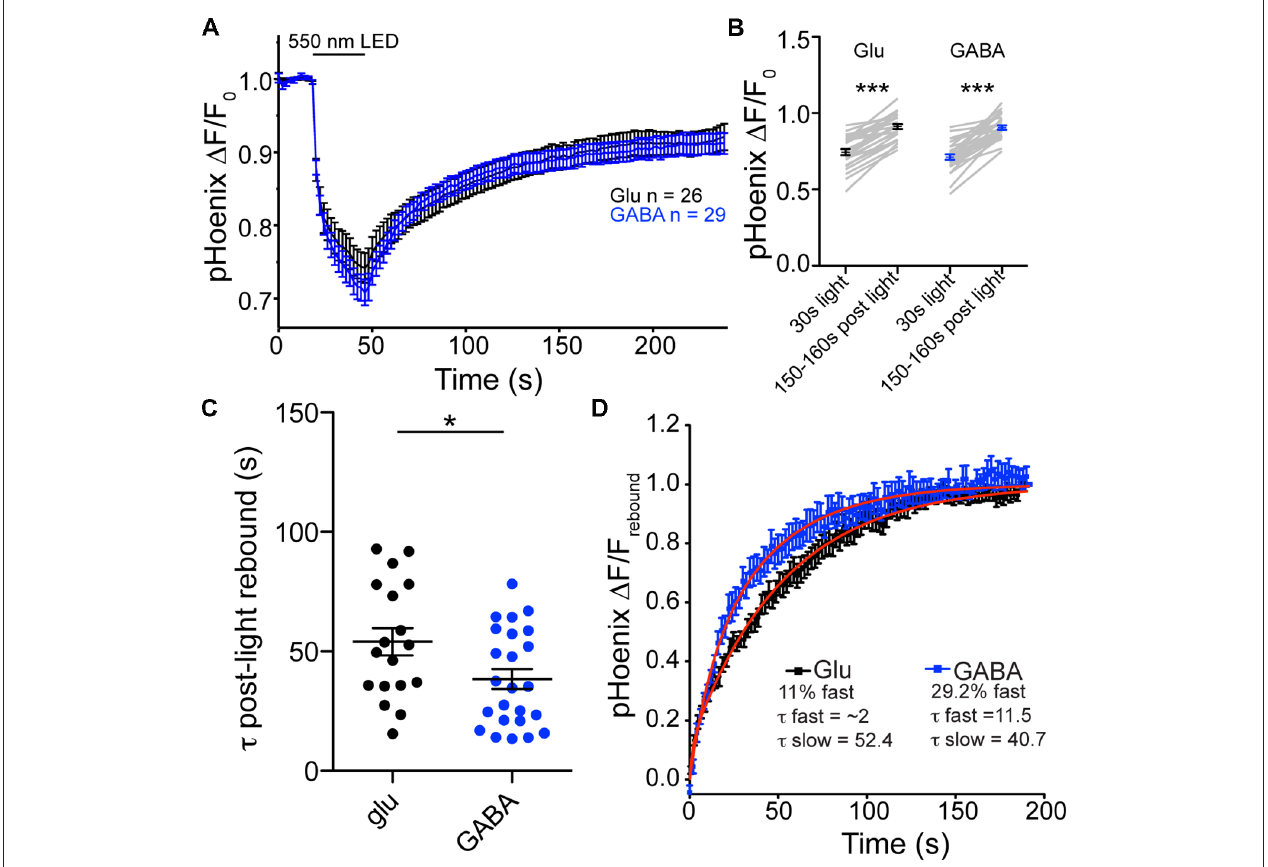
FIGURE 5 | Proton efflux is faster from GABAergic SVs than glutamatergic SVs after pHoenix-induced acidification. (A) Average decrease in pHoenix fluorescence normalized to baseline fluorescence with 550 nm light stimulation (30 s) in VGAT-cre cultures pre-treated with bafilomycin (>2 h, 1 µ M) in glutamatergic (black; n = 26 images; four independent cultures) or GABAergic (blue; n = 29 images; four independent cultures) synapses. (B) Comparison of normalized pHoenix fluorescence at time points immediately following a 30 s stimulation with 550 nm light and 150–160 s after light cessation in glutamatergic (black) and GABAergic (blue) synapses. Significance determined by paired t -test. ∗∗∗ p < 0.0001. (C) Scatter plot of τ calculated from single or double exponential fit (as determined by best fit) of rebound fluorescence after 30 s stimulation of pHoenix by 550 nm light in bafilomycin pre-treated VGAT cre cultures. Bars = Mean ± SEM. Significance determined by unpaired t -test. ∗ p = 0.0294. (D) Double exponential fit (red lines) to average rebound fluorescence set to baseline immediately after a 30 s stimulation with 550 nm light and normalized to peak rebound fluorescence 150–160 s post light per image in glutamatergic (black) and GABAergic (blue) synapses. Mean ±